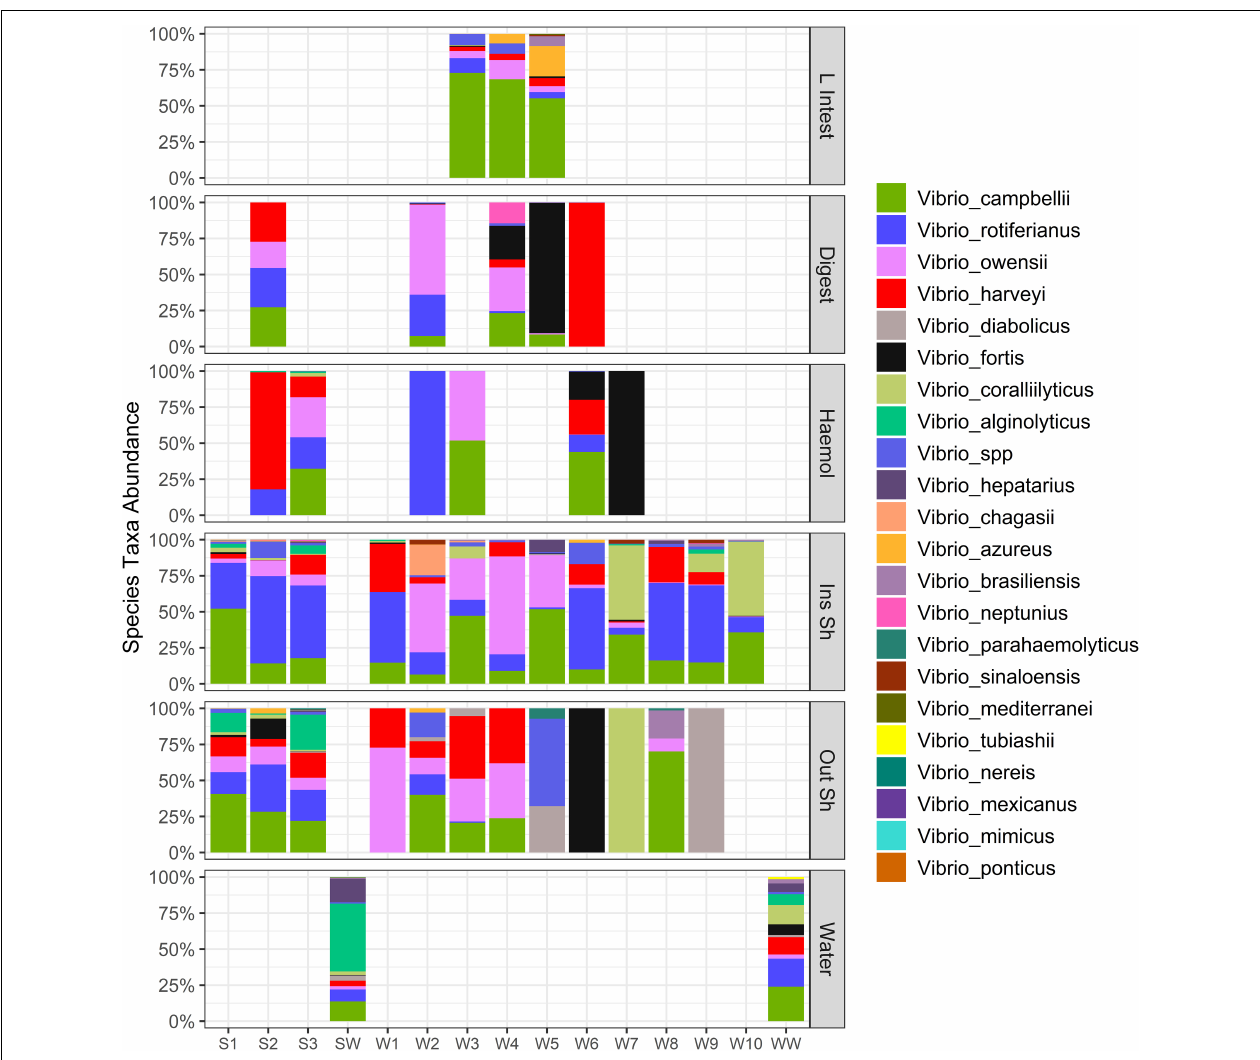
FIGURE 5 | Stacked bar plot of Vibrio species across oyster tissue types and farm water. Each column is a sample. “L Intest” large intestinal tissue, “Digest” digestive tissue, “Haemol” haemolymph, “Ins Sh” inside shell, “Out Sh” outside shell, “Water” farm water. “S,” Seaflower Bay and “W,” Wargul Wargul Bay. Only samples with > 10 sequence reads were